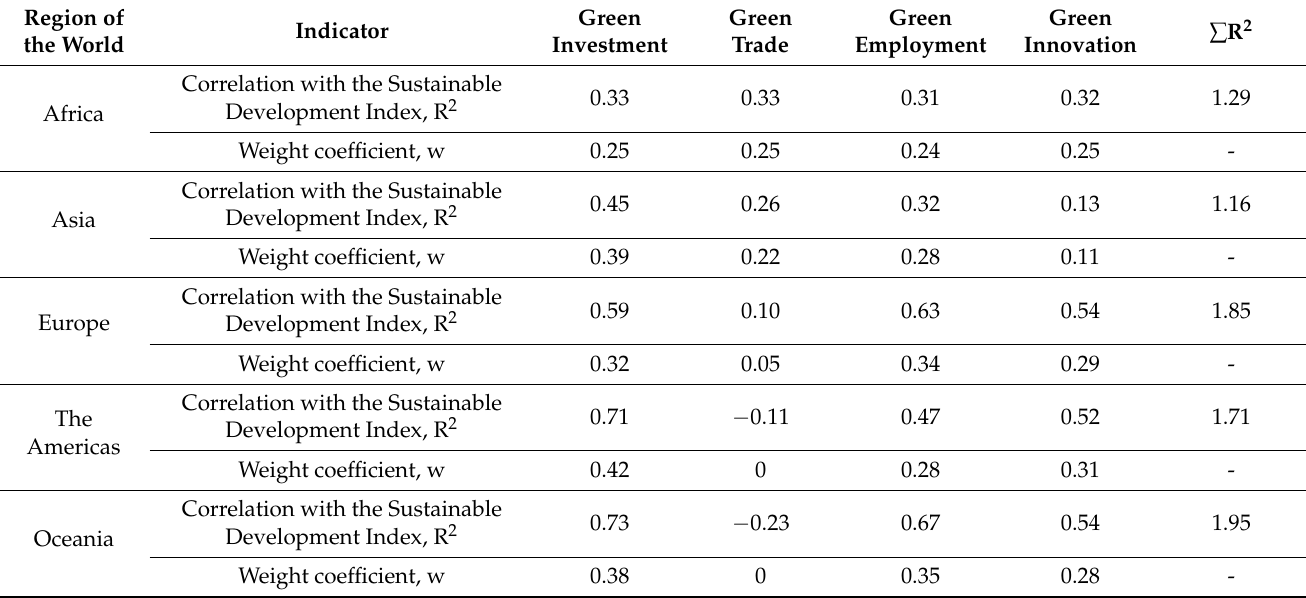
Table 2. Calculation of weight coefficients. Table 3. Calculation of arithmetic means, standardized values and weighted sums.